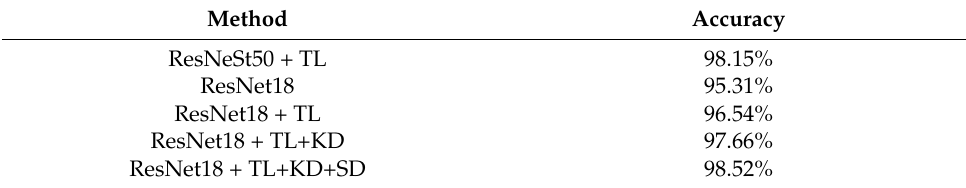
Table 3. Experimental results of ablation with different strategies on SIPaKMeD.